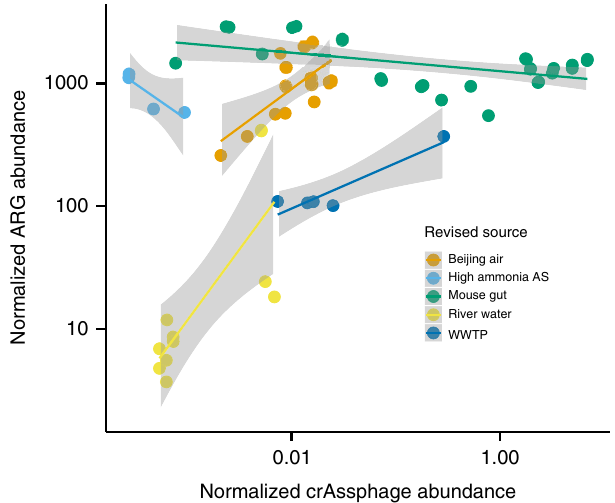
Fig. 3 The correlation between crAssphage abundance and total ARG abundance in MG-RAST metagenomes where crAssphage was detected. Only in the mice gut and sludge with high ammonia concentration we could not see a correlation (discussed in main text). Original MG-RAST feature annotations were revised manually using the project and sample descriptions due to the misleading information in original annotations. Original annotations can be seen in Supplementary Data lower detection limit could give better results. Due to the low detection frequency, we did not use ɸ B124-14 in this study to detect possible selection hotspots.